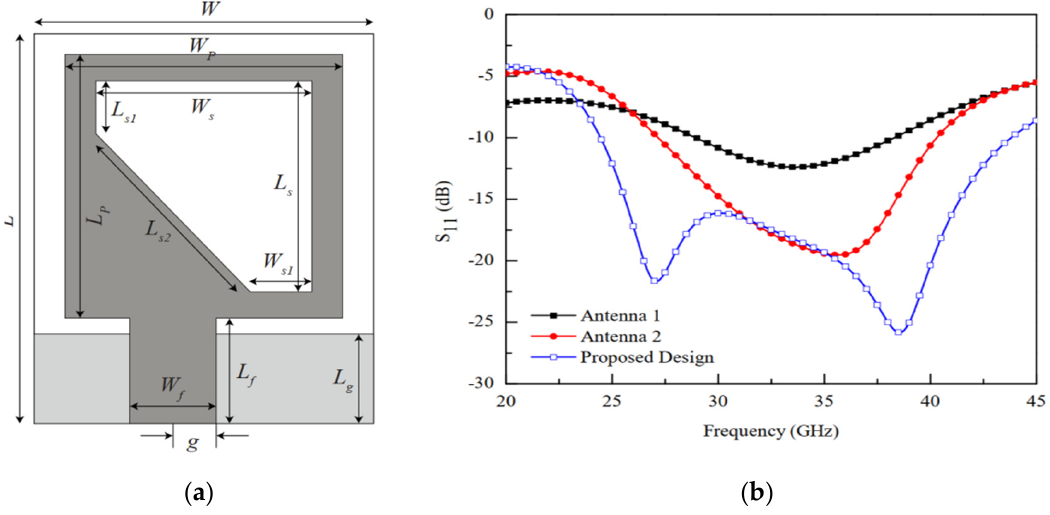
Figure 11. Proposed patch antenna with triangular slot loaded. ( a ) Top view. ( b ) Enhancement in bandwidth due to slot in blue [31].